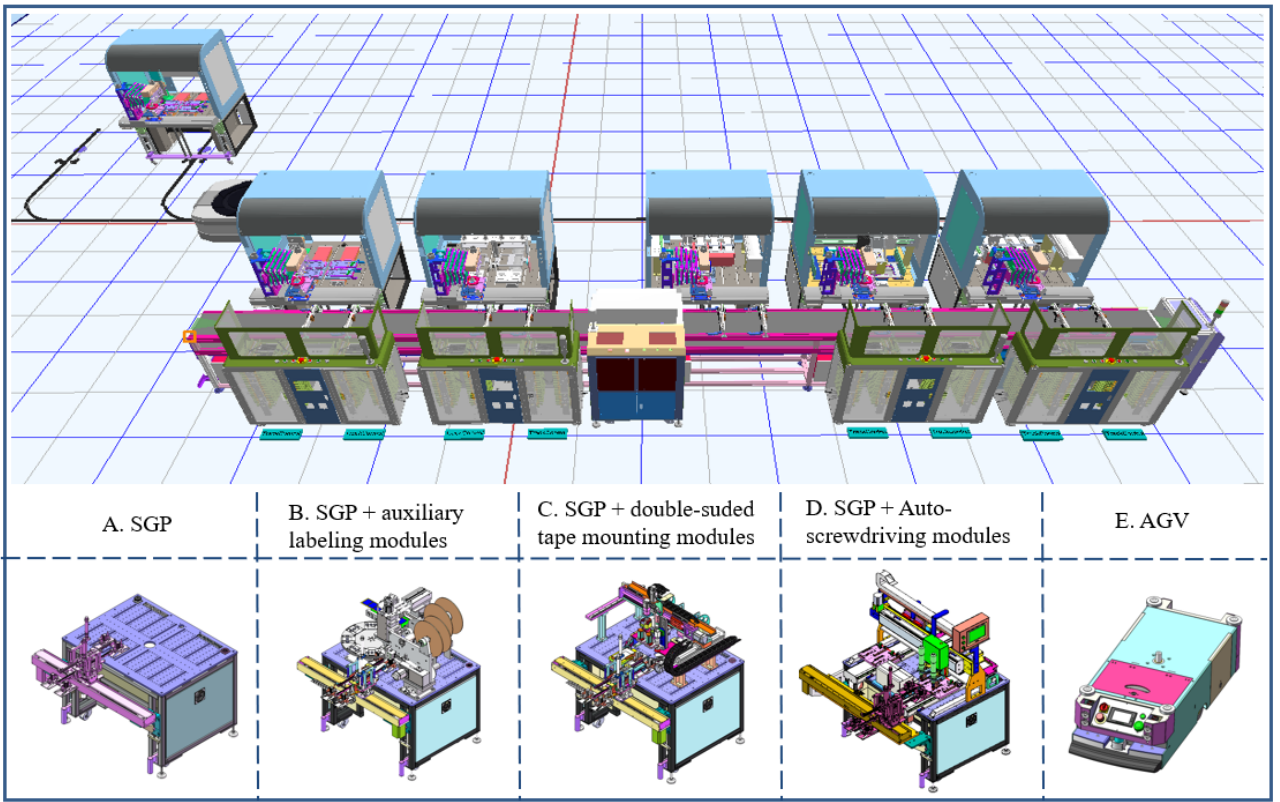
Figure 3. Virtual assembly line and its components.